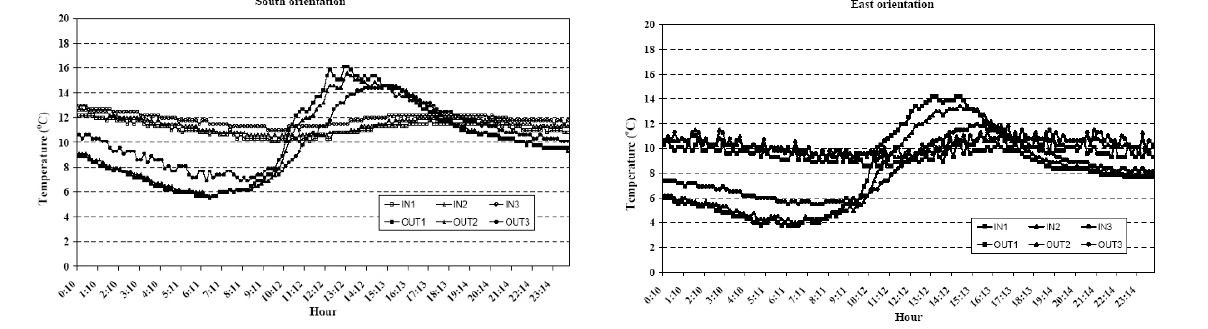
of decrease in emitted heat by radiation and the decrease in free convection